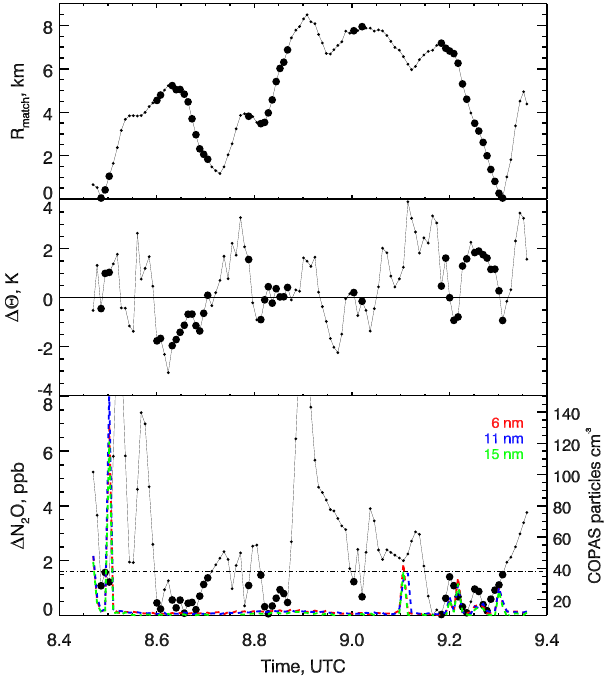
Fig. 6. Performance of the match-flight. The upper panel and the middle panel show the horizontal and the vertical match accuracy in terms of match radius R match (in km) and potential temperature dif- ference 12 (in K), respectively. Differences in the mixing ratios of N 2 O are shown in the lower panel. The red, blue and green dashed lines correspond to the COPAS measurements. The increase of par- ticle number concentrations indicates the Geophysica exhaust trail encounters. The large black circles show the 41 matches fulfilling the conditions described in Sect.